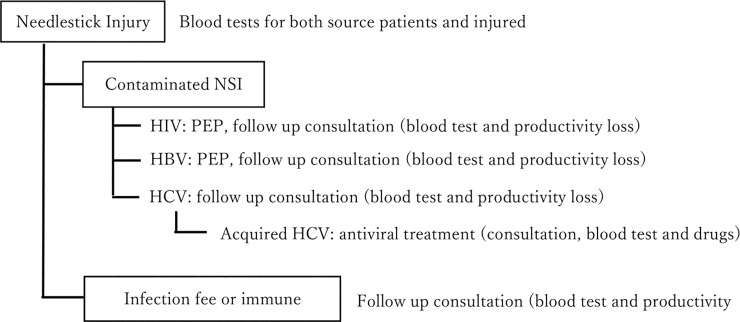
Model structure.